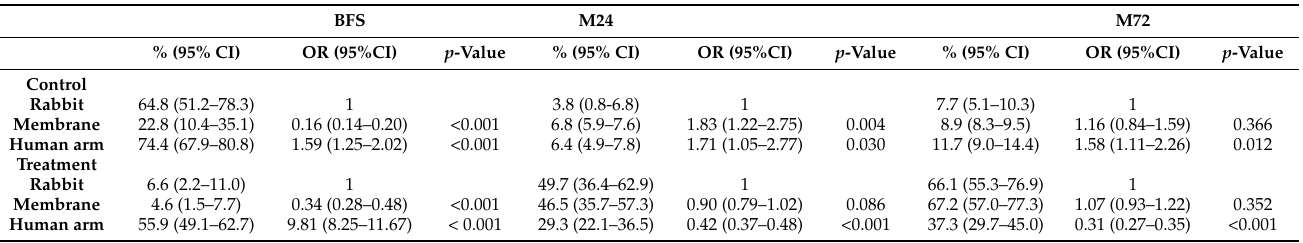
Table 2. Impact of bait on mortality and blood-feeding adjusted for the net condition. The difference in the odds of mosquito mortality at 24-h (M24) or 72-h (M72) and blood feeding success (BFS) for 100 pyrethroid-resistant Anopheles arabiensis exposed to Interceptor ® and Interceptor ® G2 with either a rabbit, human arm or membrane feeder as bait